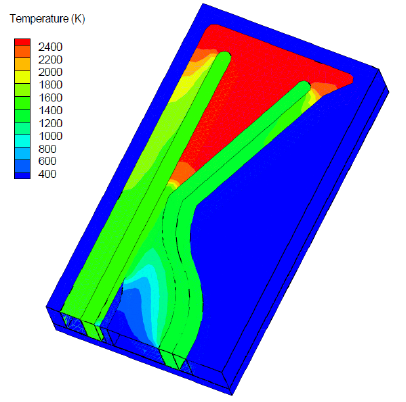
Figure 6. Numerical study of micro-combustor design for optimization of methane and air mixing by Badra and Masri [15]. 3D Temperature contours using aluminum as the conductive